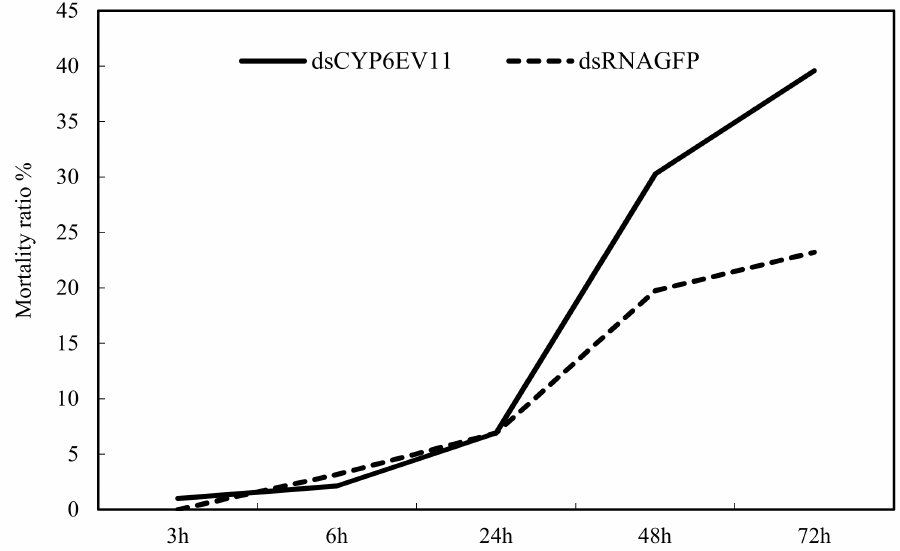
Figure 7. The mortality rates of C. kiiensis larvae with CYP6EV11 gene silencing under phenol stress. The larvae were soaked in the mixture phenol at 1 µ M and dsRNA at 2 µ g/ µ L, and the groups soaked in dsGFP were regarded as controls to compare the susceptibility to phenol after CYP6EV11 gene